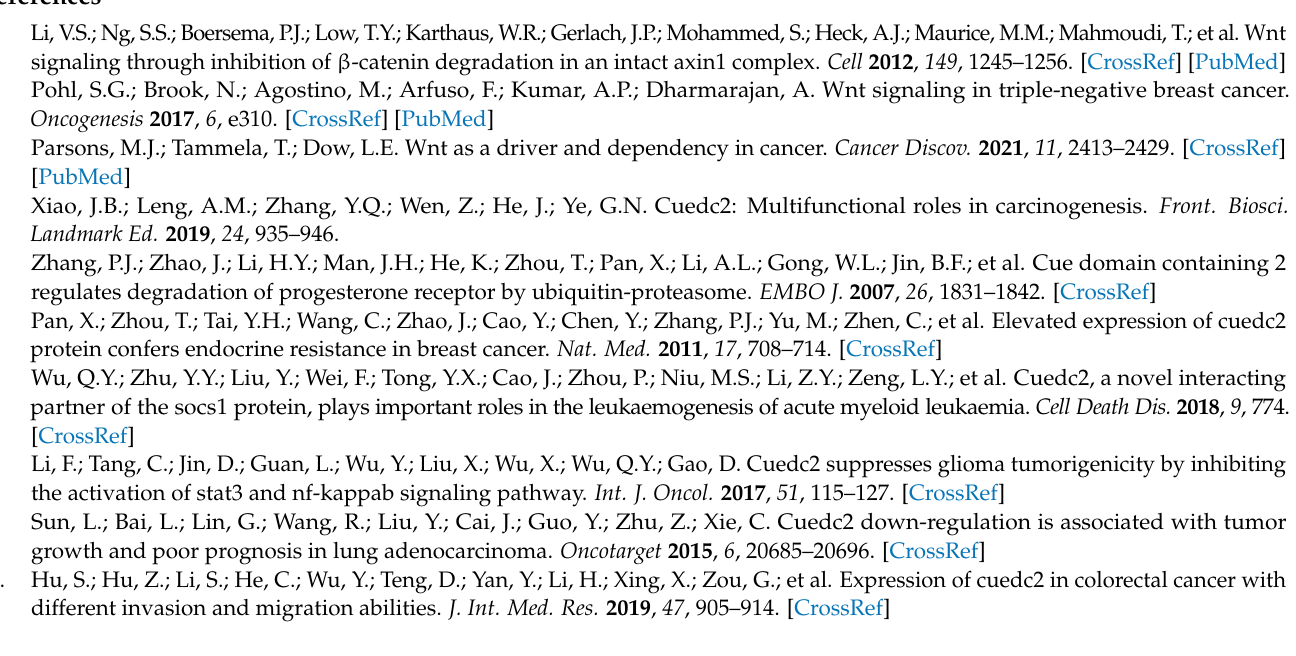
protein expressions.; Figure S3: Statistical results for Figure 4M; Figure S4: Statistical results for Figure 5D; Figure S5: Effects of XAV-939 on β -catenin protein levels (A) and effects of S3I-201 on STAT3